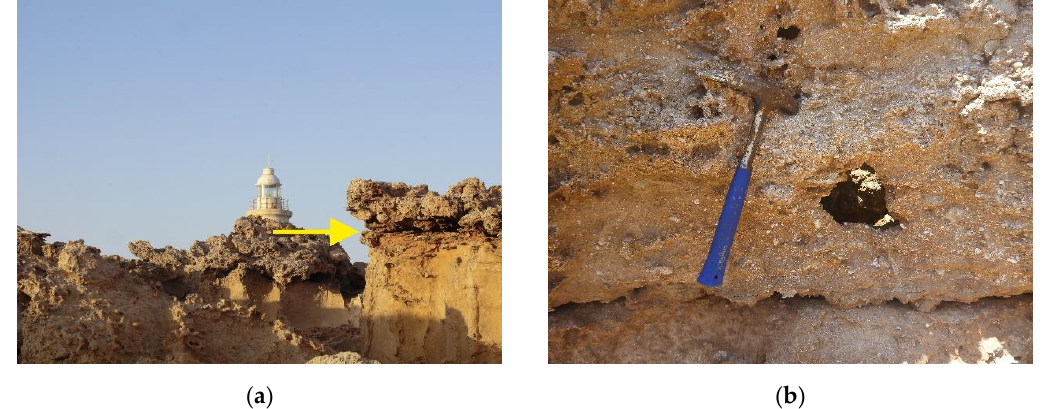
Figure 10. (a) The subaerially eroded red horizon that has acted as a detachment zone is indicated by a yellow arrow; (b) detailed view of this detachment zone.